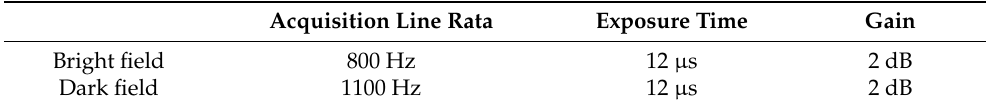
Table 7. Camera’s specific